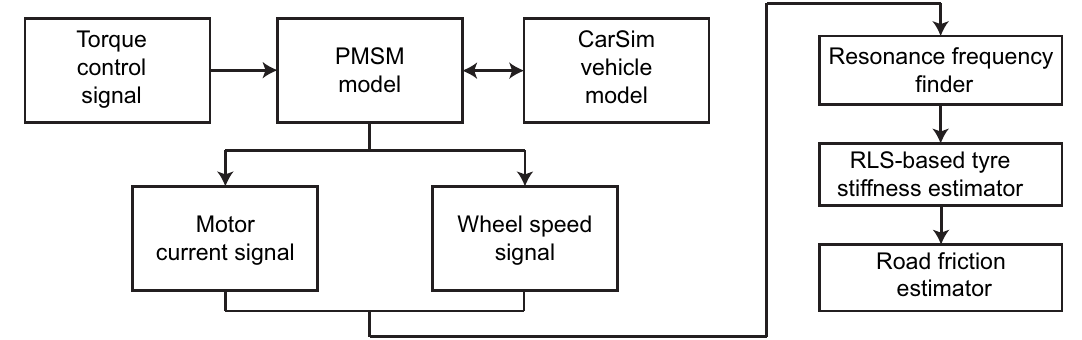
Figure 22. Estimation structure presented by Chen et al. [4].